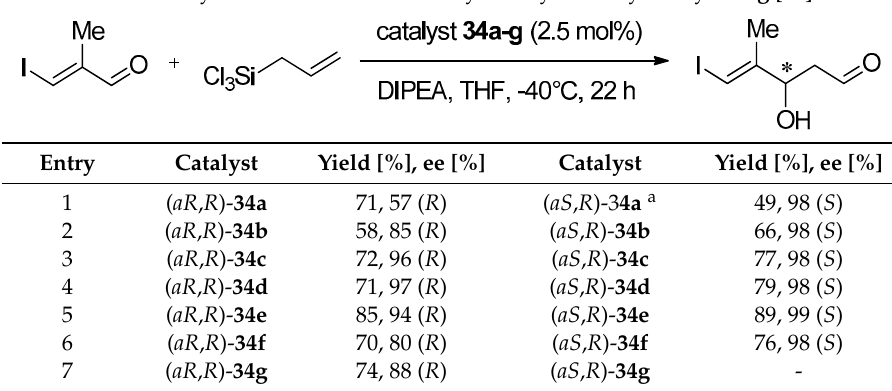
Table 7. Allylation of E -3-iodomethacrylaldehyde catalyzed by 34a – g [54].